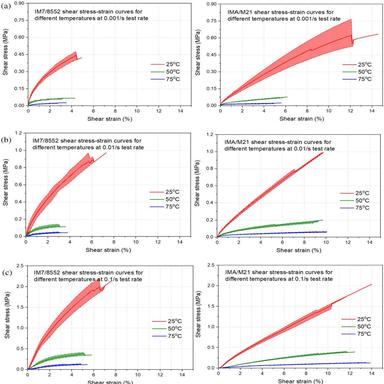
Influence of temperature on the measured shear stress versus shear strain curves (left - IM7/8552 and right - IMA/M21) at test rates of (a) 0.001/s, (b) 0.01/s and (c) 0.1/s. (For interpretation of the references to colour in this figure legend, the reader is referred to the web version of this article.)